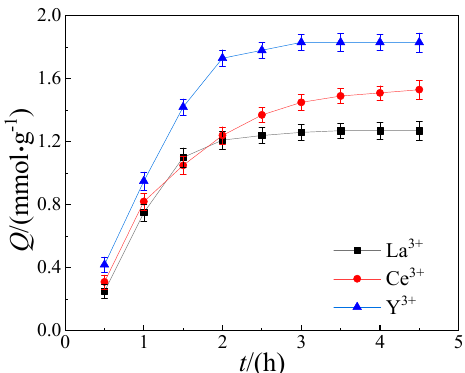
Figure 4. E ff ect of contact time on the resin ( C 0 = 0.01 mol · L − 1 ; T = 40 ◦ C pH for La 3 + , Ce 3 + , and Y 3 + were 2.0, 1.0, and 3.0, respectively). Figure 4. Effect of contact time on the resin （ C 0 = 0.01 mol·L − 1 ; T = 40 ℃ ; pH for La 3+ , Ce 3+ , and Y 3+ were 2.0, 1.0, and 3.0, respectively).